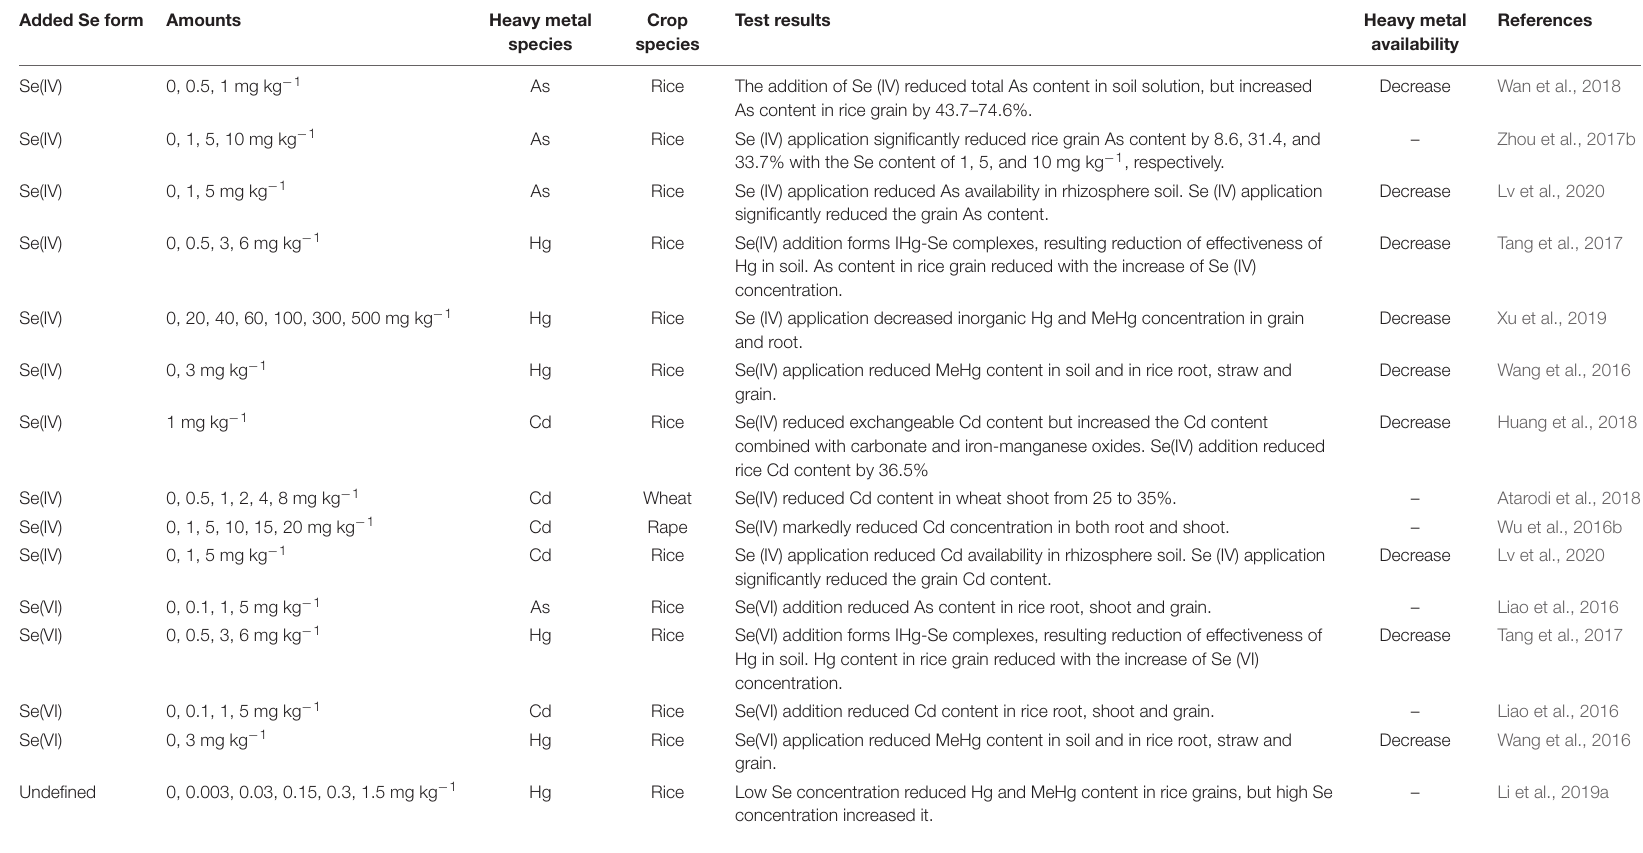
TABLE 3 | Research progress on the effects of Se on accumulation of heavy metals in higher plants.